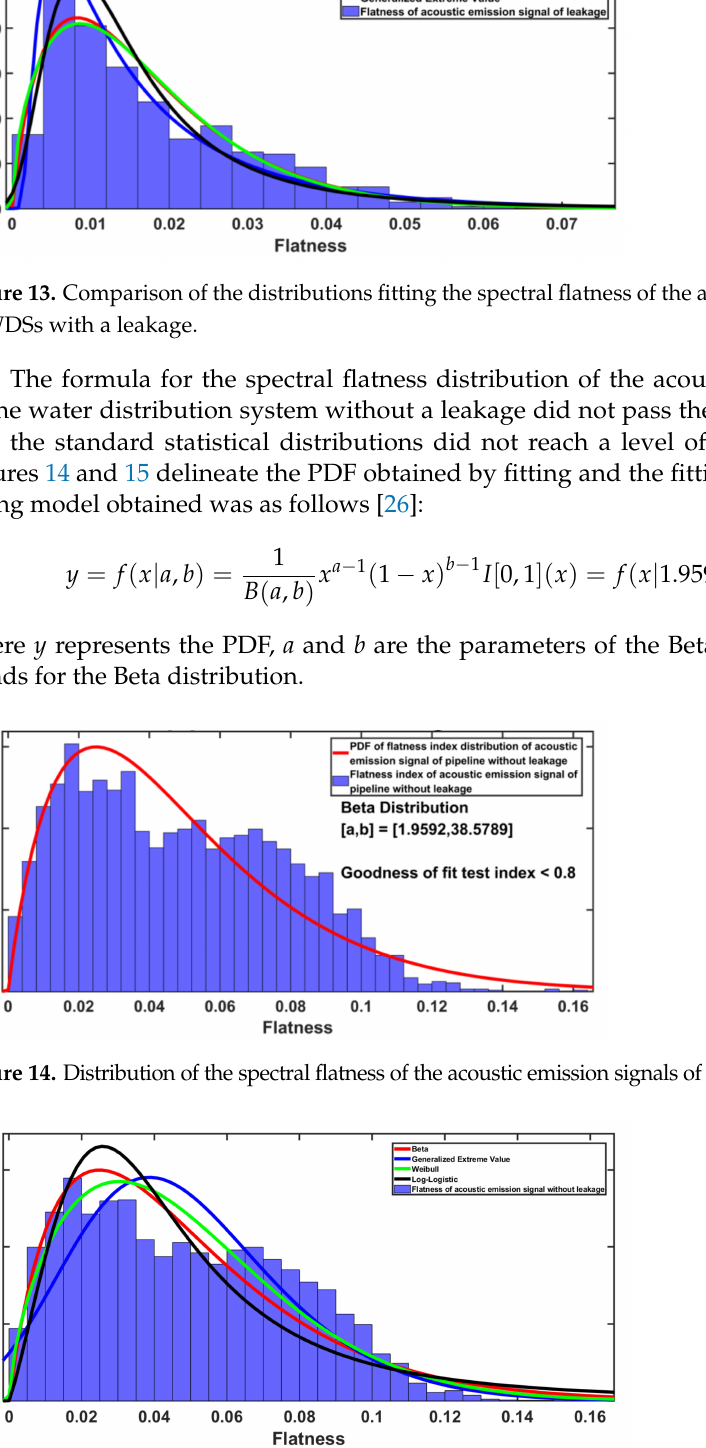
Figure 15. Comparison of the distributions fitting the spectral flatness of the acoustic emission signals of WDSs without a